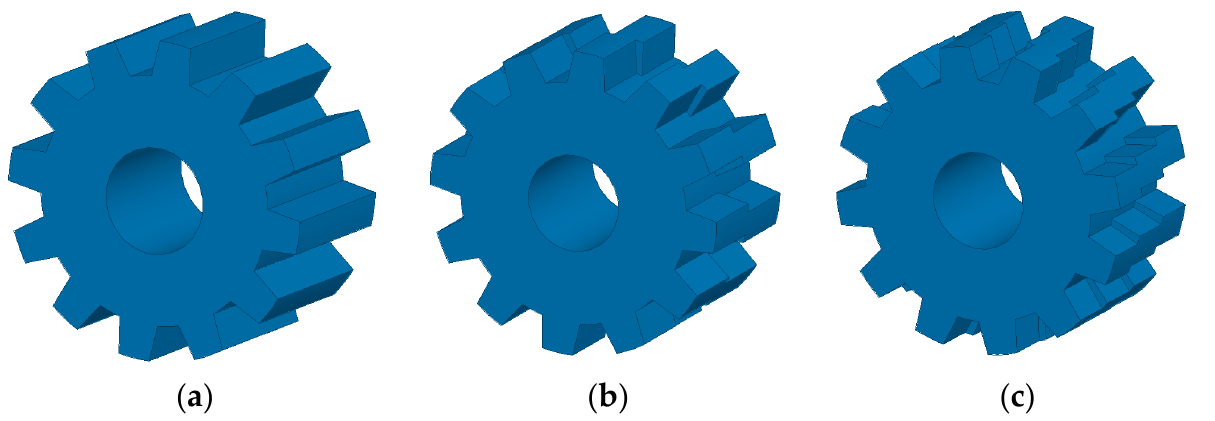
Figure 14. Rotor for FRCPM with different configurations: ( a ) initial design; ( b ) 2 segments with 2.5 degrees shift; ( c ) 3 segments with 2.5 degrees shift.